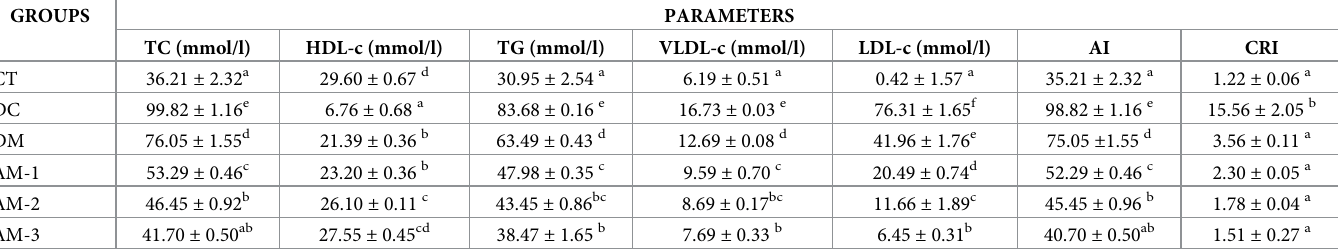
Table 8. Lipid profile of alloxan-induced diabetic rats after oral administration of aqueous extract of A . muricata peels seeds.